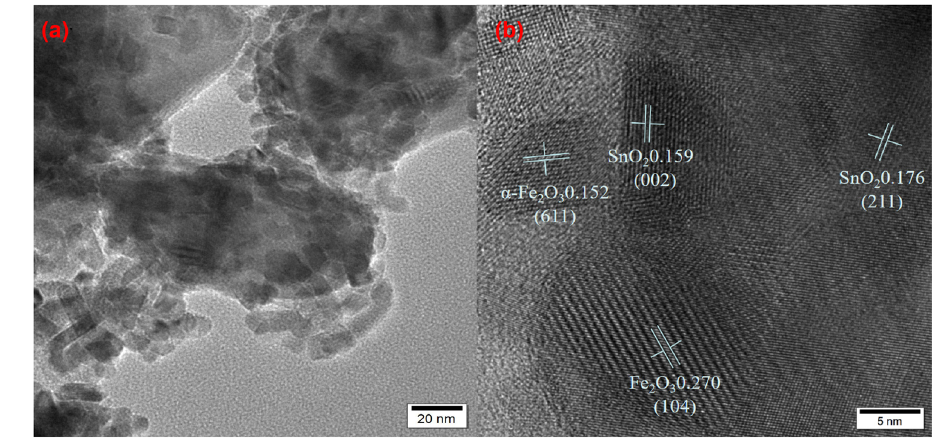
Figure 3: TEM image ( a ) and HRTEM image ( b ) of Fe – Sn – O catalyst calcined at